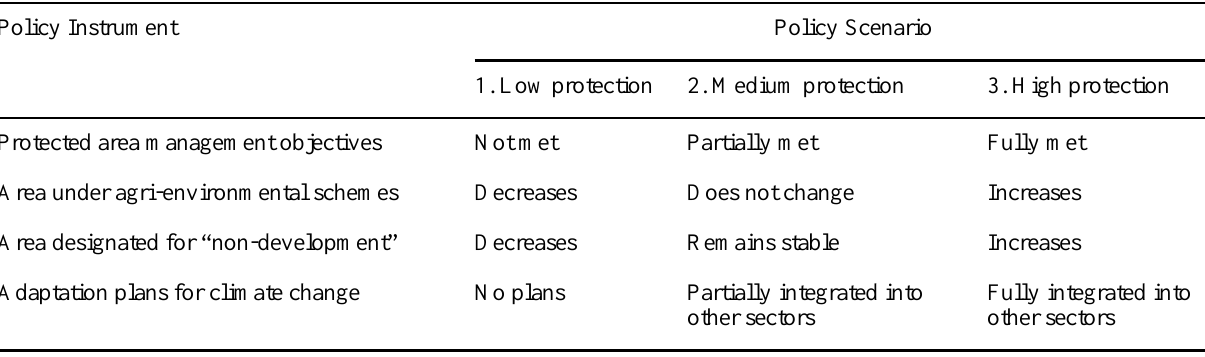
Table 2 . Biodiversity policy scenarios for